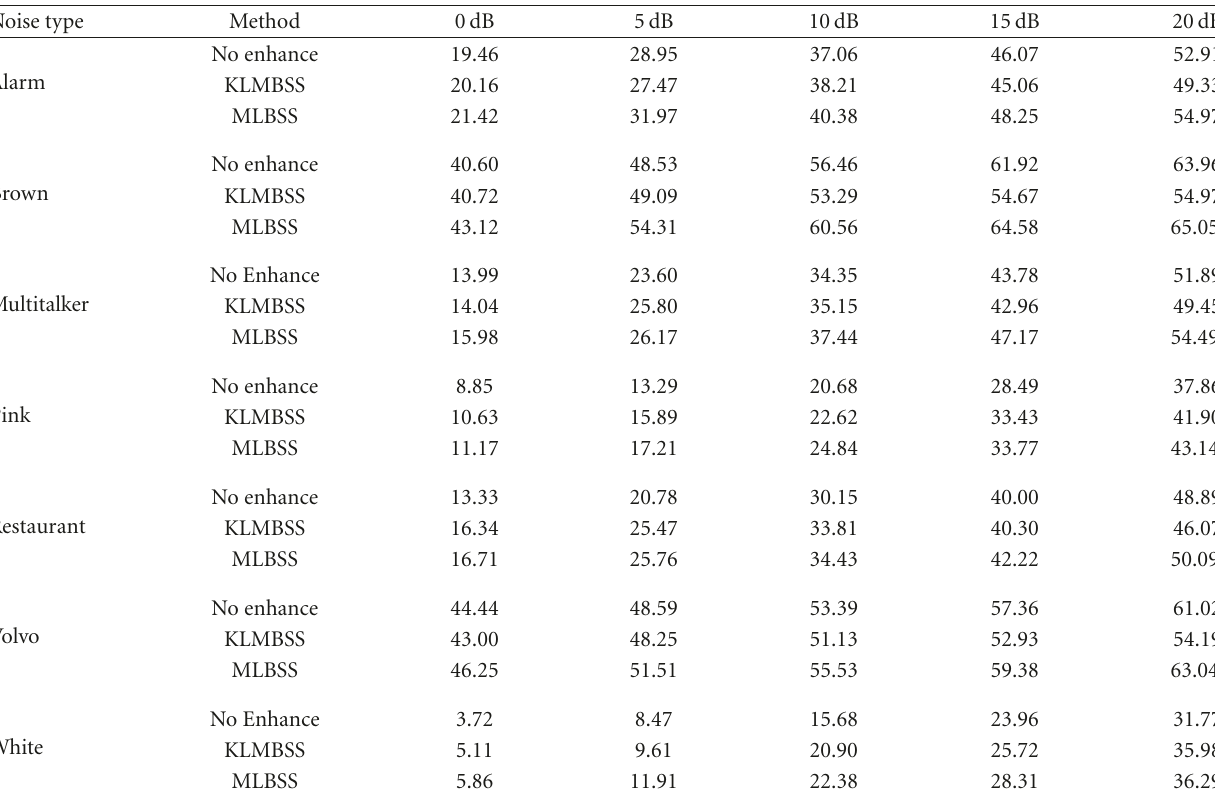
Table 4: Phoneme recognition accuracy (%) on TIMIT